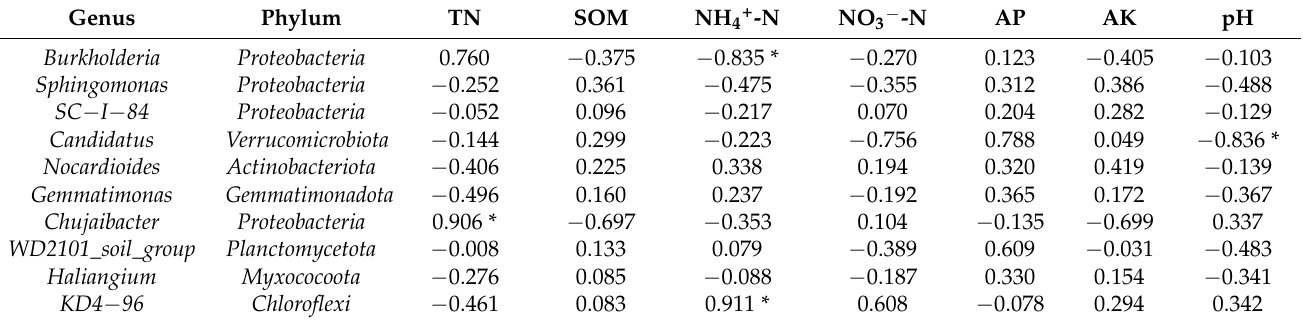
Table 3. The Spearman’s correlations between soil properties and bacterial abundance at the genus